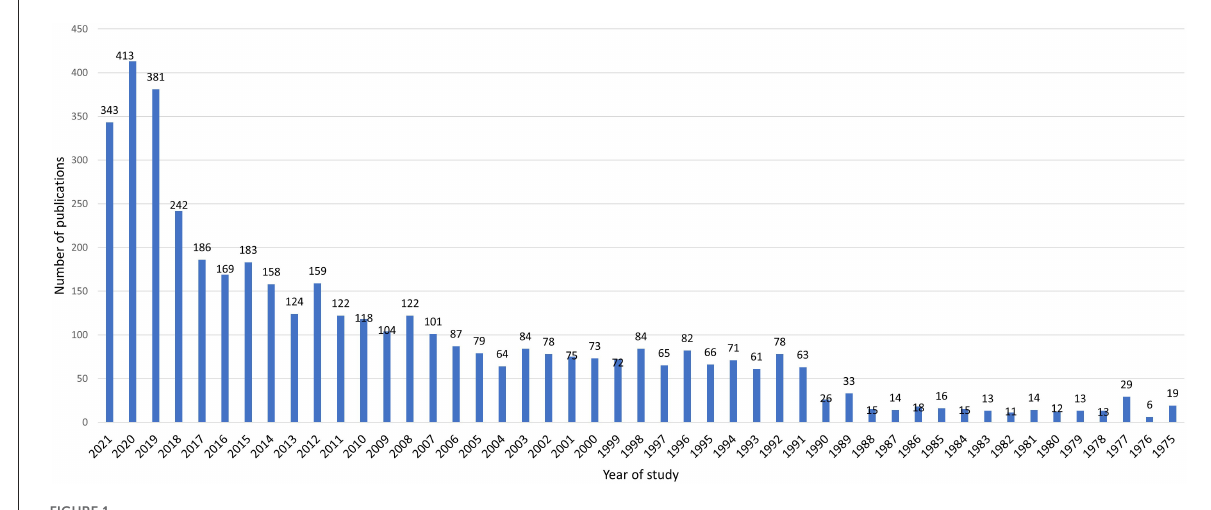
FIGURE1 The process of publishing articles on occupational diseases over the past 46 years.